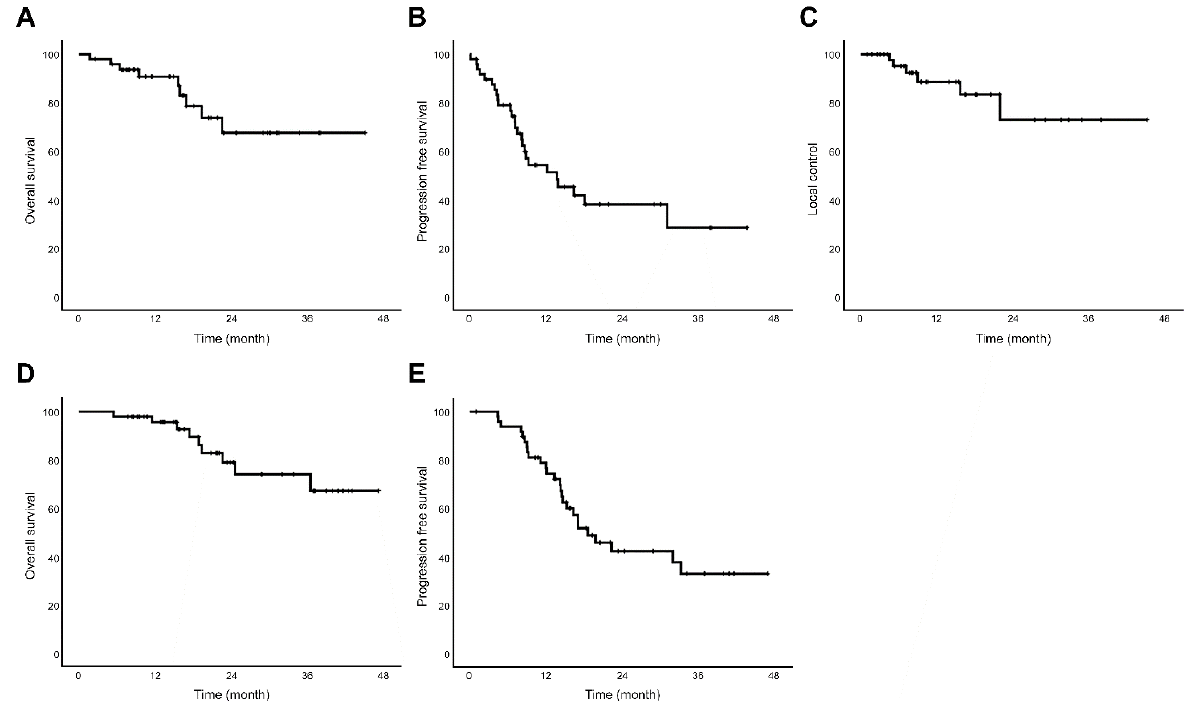
Figure 2. Kaplan–Meier survival curves of all enrolled patients treated with stereotactic body proton beam therapy ( n = 49) ( A ) Overall survival ( B ) Progression-free survival ( C ) Local control rate ( D ) Overall survival from start date of treatment course ( E ) Progression-free survival from start date of treatment course. Table 2. Univariable and multivariable Cox proportional hazard model for progression-free sur- vival ( n = 49).